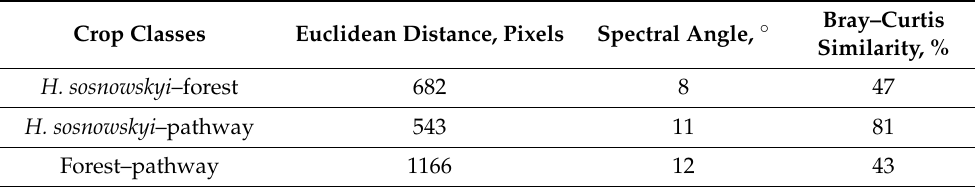
Table 2. Results for spectral characteristics for pairs of